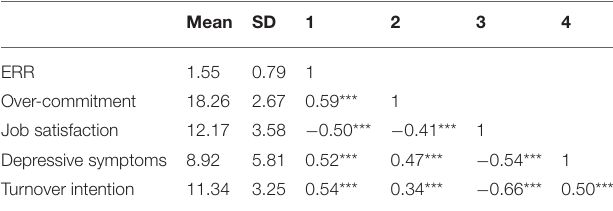
TABLE 2 | Means, standard deviations, and correlations among study variables ( n = 10457).